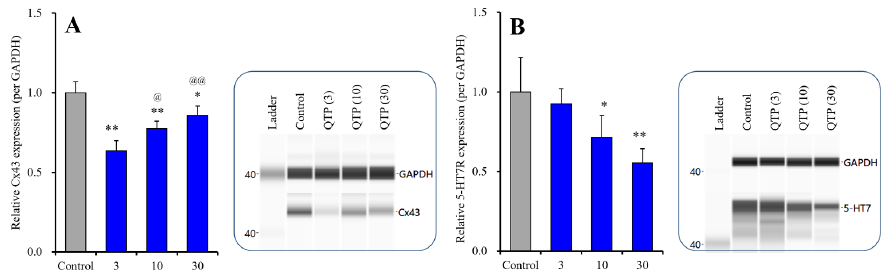
Figure 5. Concentration-dependent effects of subchronic administration (7 days) of QTP on protein expression of Cx43 in the cytosol fraction ( A ) and 5-HT7R in the plasma membrane fraction ( B ) of cortical primary cultured astrocytes. In left side histograms, ordinate: mean ± SD (n = 6) of the rela- tive protein level of Cx43 and 5- HT7R per GAPDH. Abscissa: QTP level (μM). * p < 0.05, ** p < 0.01: relative to control (QTP free), @ p < 0.05, @@ p < 0 .01: relative to 3 μM QTP in panel A by one -way ANOVA with Tukey’s post hoc test. Right side panels indicate their pseudo -gel images, using ca-